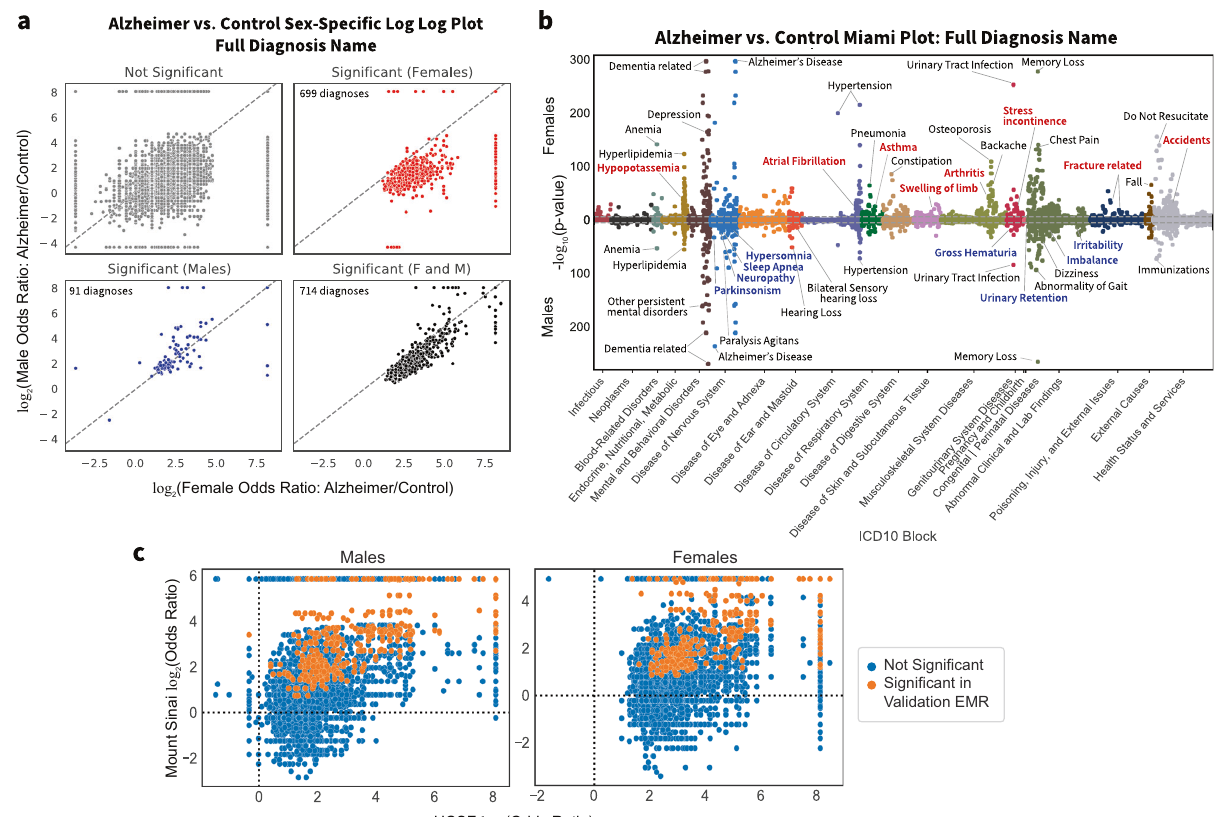
Fig. 5 Comorbidity enrichment analysis identi fi es sex-speci fi c enriched diagnoses in AD vs. control cohorts. a Full diagnosis names compared between patients with AD and controls within each sex. The log2 of the odds ratio for each sex is plotted on the axis, and points are colored by signi fi cance (Bonferroni-corrected, p -value cutoff > 3e − 6). b Miami plot of the diagnosis names grouped by sex and ICD-10-CM categories. Select top diagnoses are labeled, with diagnosis names colored by signi fi cance as female-only (red), male-only (blue), or signi fi cant in both sexes (black). c Correlation plots of AD vs. control odds ratios between UCSF and Mount Sinai for diagnoses that are signi fi cant at UCSF for each sex group (two-sided Fisher ’ s exact or Chi- squared test, Bonferroni-corrected p -value threshold of 0.05). Each dot represents a diagnosis, and dots in orange are signi fi cant at Mount Sinai (two-sided Fisher ’ s exact or Chi-squared test with Bonferroni-corrected p -value threshold of 0.05 based on the number of signi fi cant UCSF diagnoses for each sex